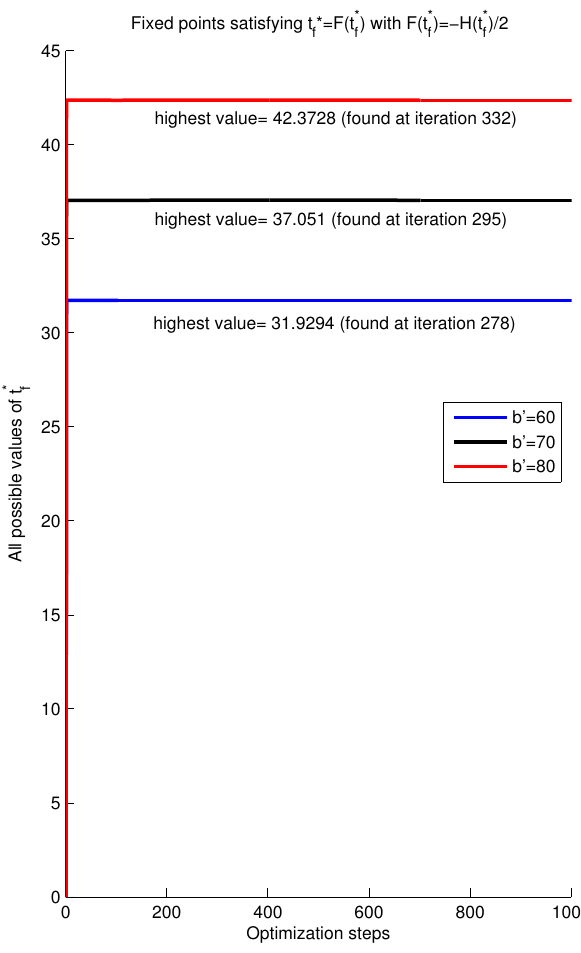
Figure 3. t ∗ for different values of b (cid:48) with the same parameters, initial conditions and severity weights f constants as in Figure